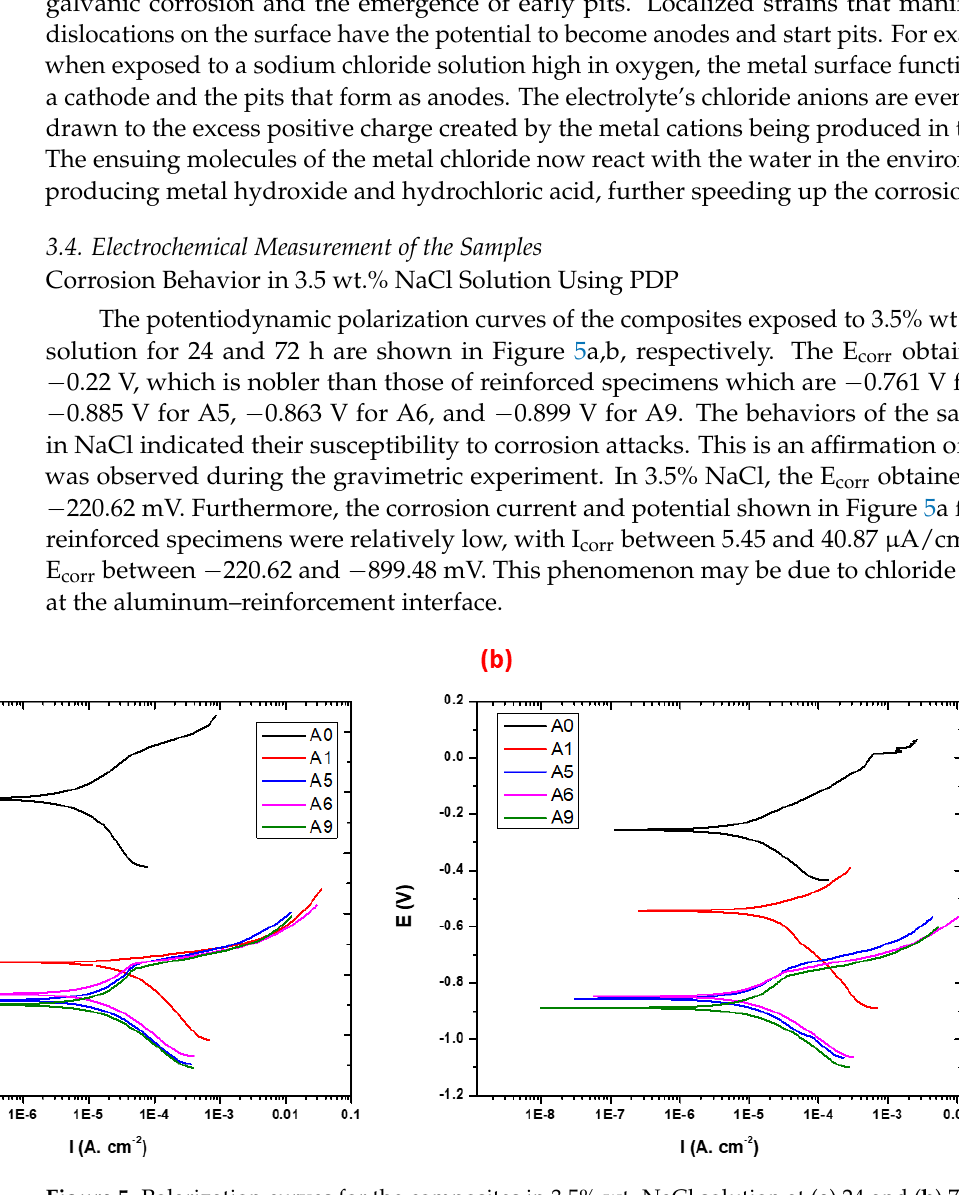
Figure 5. Polarization curves for the composites in 3.5% wt. NaCl solution at ( a ) 24 and ( b ) 72 h.